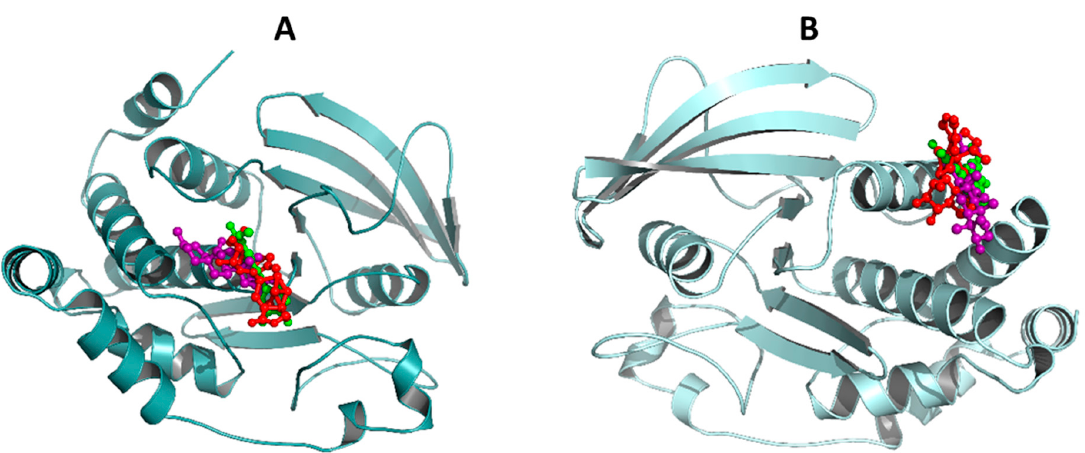
Figure 2. Structural models of the binding sites of the PTP-1B ligand complexes. In cyan cartoons (PTP-1B protein), red sticks ( 1 ), green sticks ( 7 ) purple sticks ( UA ) at the catalytic ( A ) and allosteric sites ( B ). Images created with Pymol.